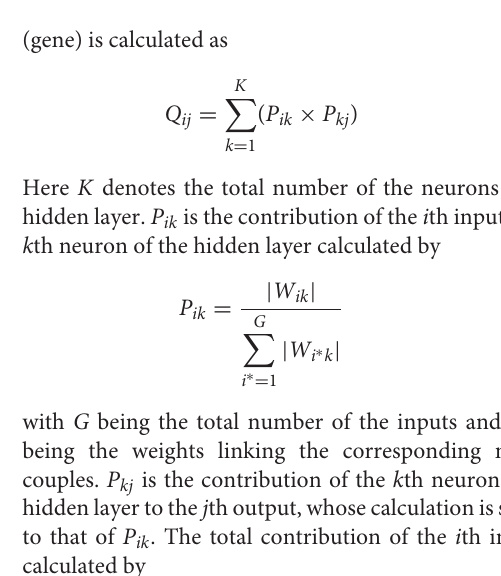
0.632 N sample bootstrapping ⌈ × ⌉